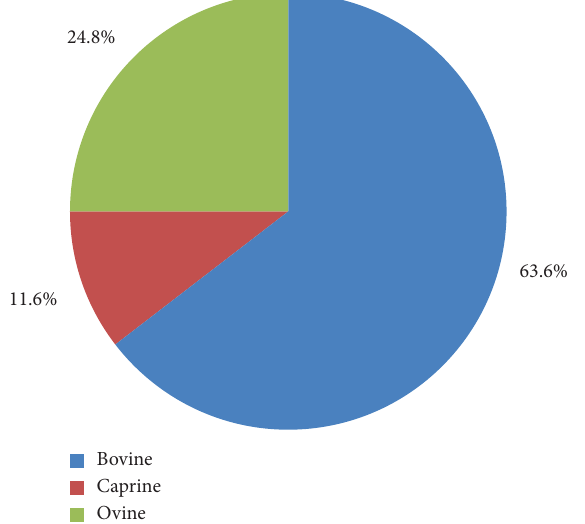
Figure 2: Distribution of blood samples collected per species in Nandi county, Kenya